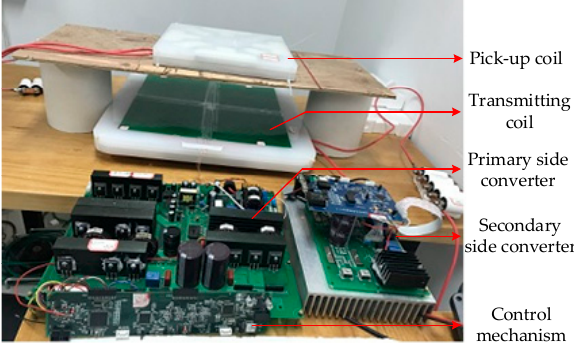
Figure 14. The diagram of experimental device.